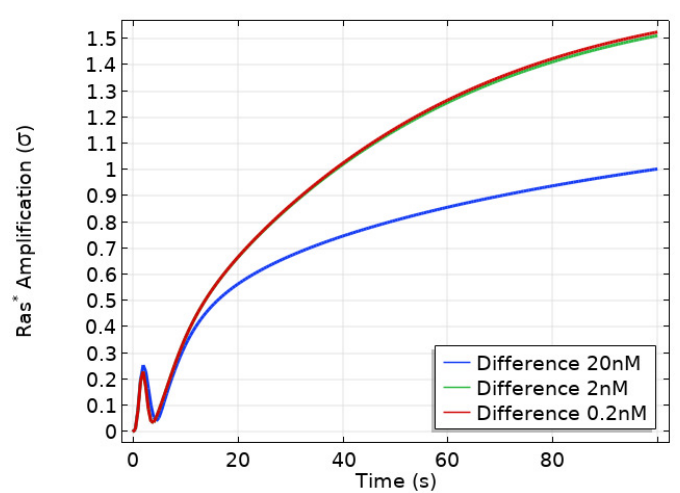
Figure 22. Amplification, as defined in [133], of the Ras signal in an unpolarized cell in a linear gradient with mean 10 nM and front-to-back differences as